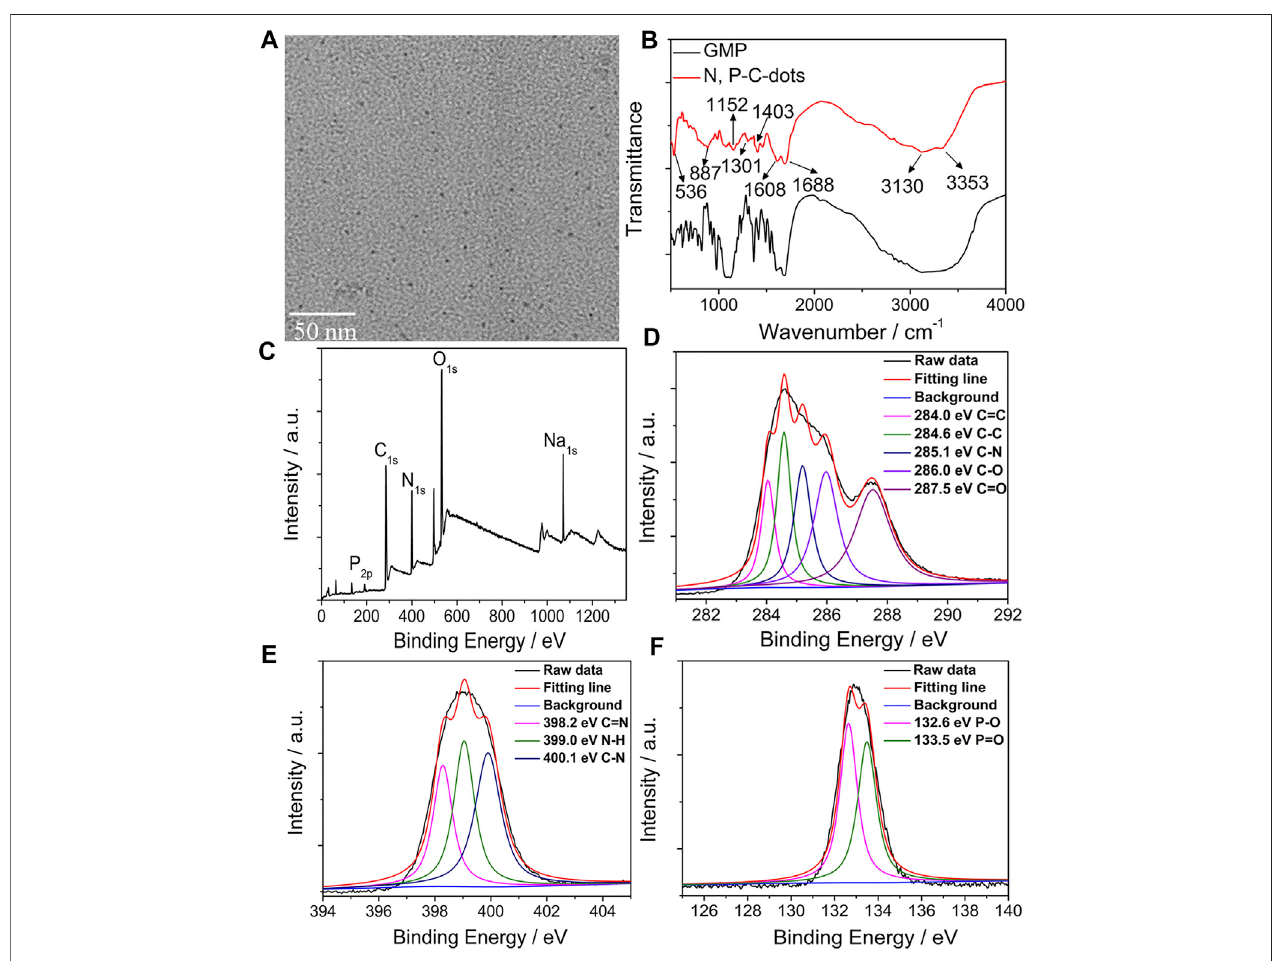
FIGURE 1 | TEM images (A) , FT − IR spectrum (B) , and XPS spectrum (C) and high-resolution C 1s (D) , N 1s (E) , and P 2p (F) XPS spectrum of the N/P CDs.